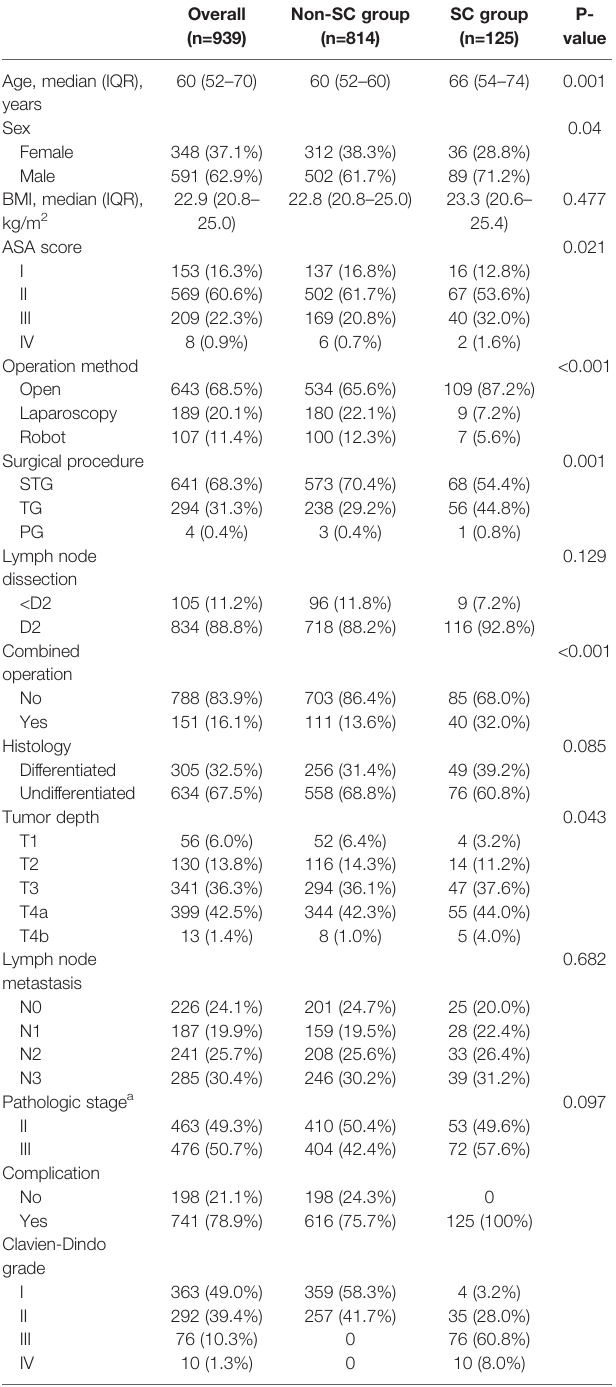
TABLE 1 | Comparison of clinicopathologic characteristics according to serious complications.